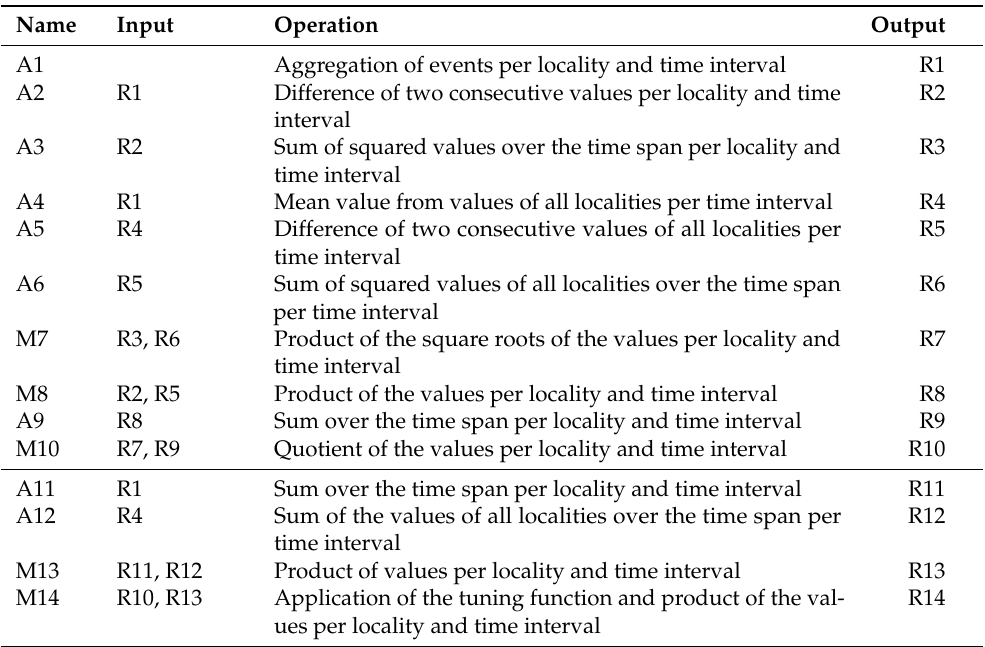
Table 1. Detailed description of